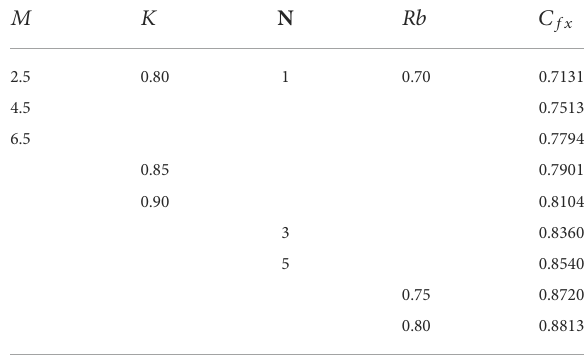
TABLE 5 Consequence of Pr , N t , Ec on Nusselt number; from table 5, we see that Nu is the growing function of Pr , N t , Ec . Actually, by